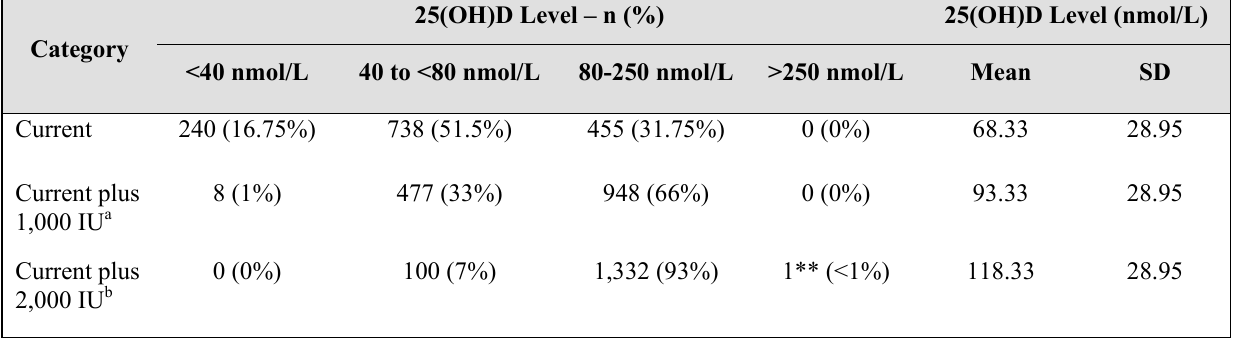
Table 7. Projected Vitamin D Status with Daily VTD